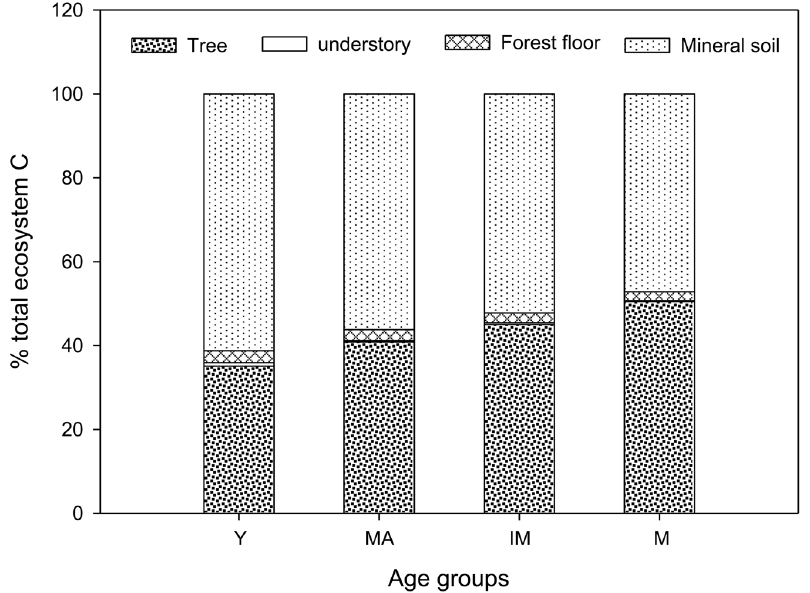
Figure 5. Percentage contribution of C pool in individual components of ecosystem in the young (Y), middle-aged (MA), immature (IM), and mature (M) P.tabulaeformis forests .